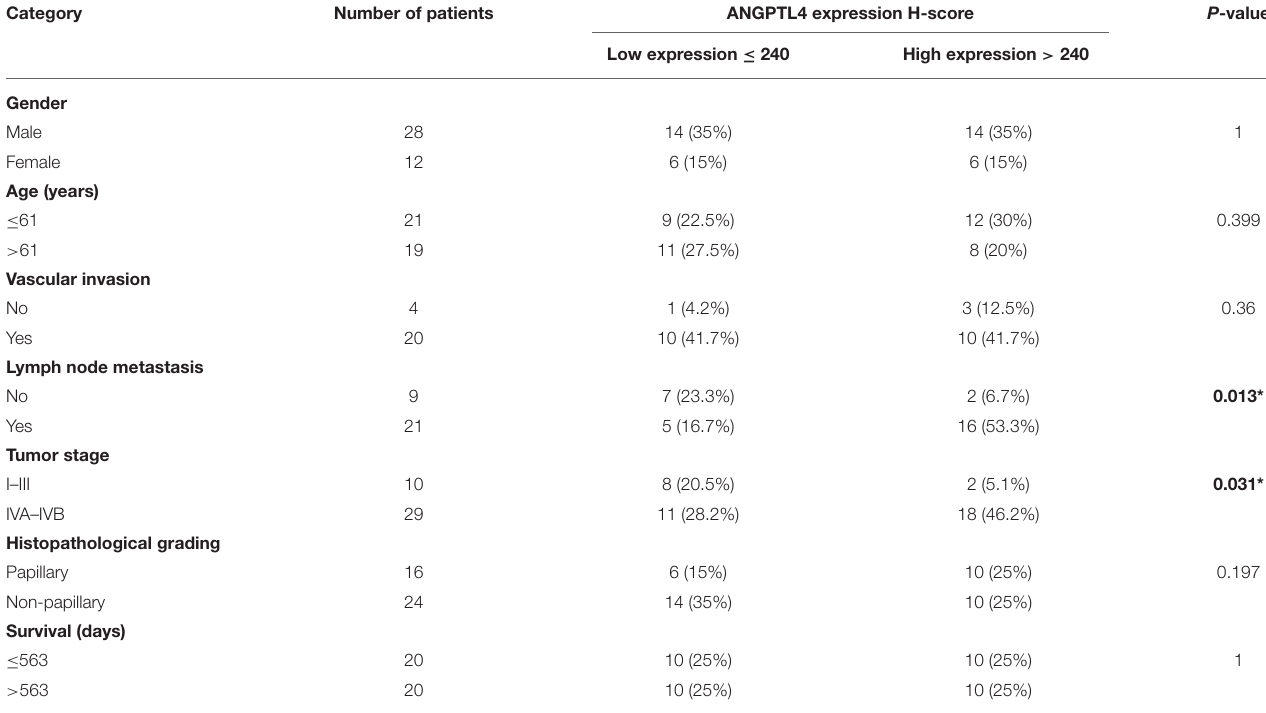
TABLE 1 | Association between ANGPTL4 expression and clinicopathological data of CCA patients. Category Number of patients ANGPTL4 expression H-score P -value Low expression ≤ 240 High expression > 240